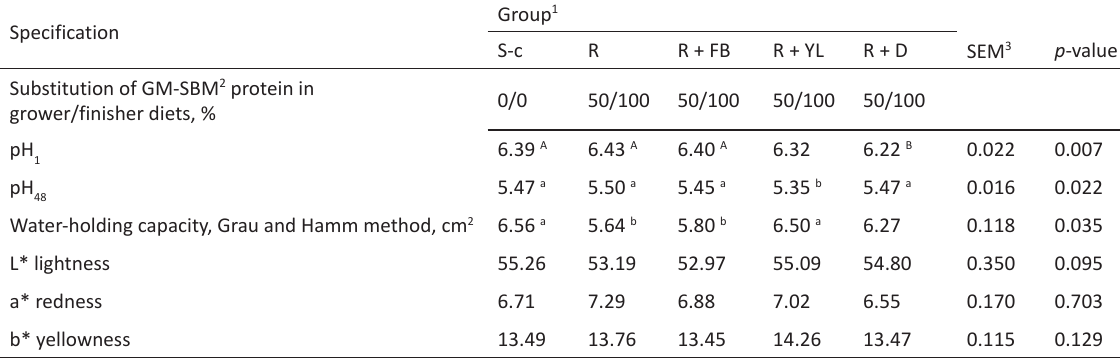
1 – refer to Table 2; 2 = genetically modified soybean meal; within rows, means followed by different letters are significantly different at p ≤0.05 ( a, b ) and p ≤0.01 ( A, B ); SEM – standard error of the mean